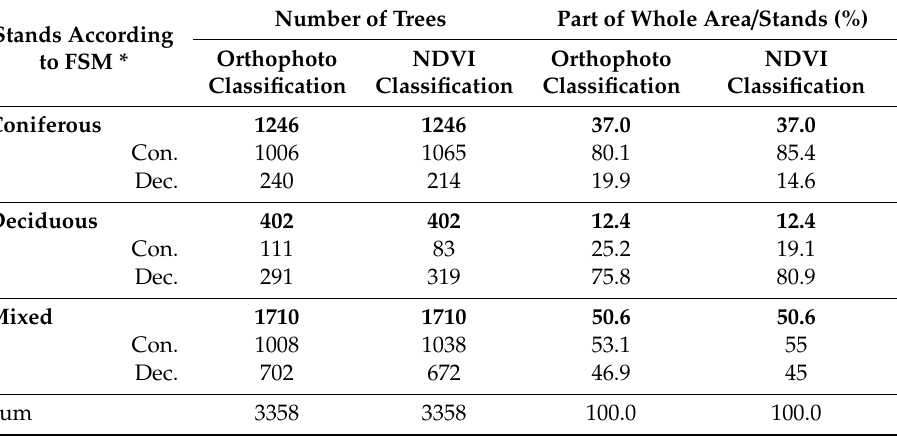
Table 2. Deciduous and coniferous trees were assigned to stands according to the forest stand map [77] (values in bold: total values – number of trees or percentage – for each of the three stand types throughout the whole area).